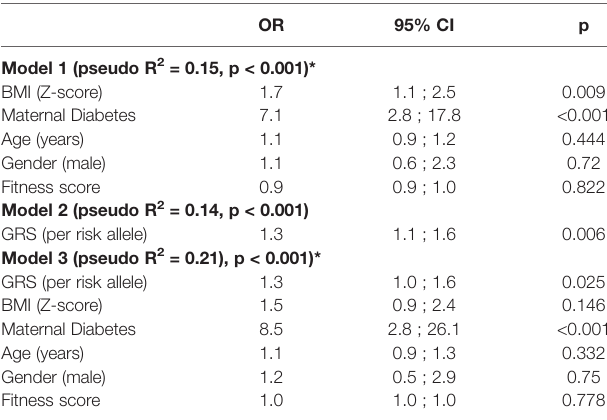
TABLE 3 | Logistic regression for pediatric-onset type 2 diabetes using clinical risk factors and the genetic risk score as predictors.